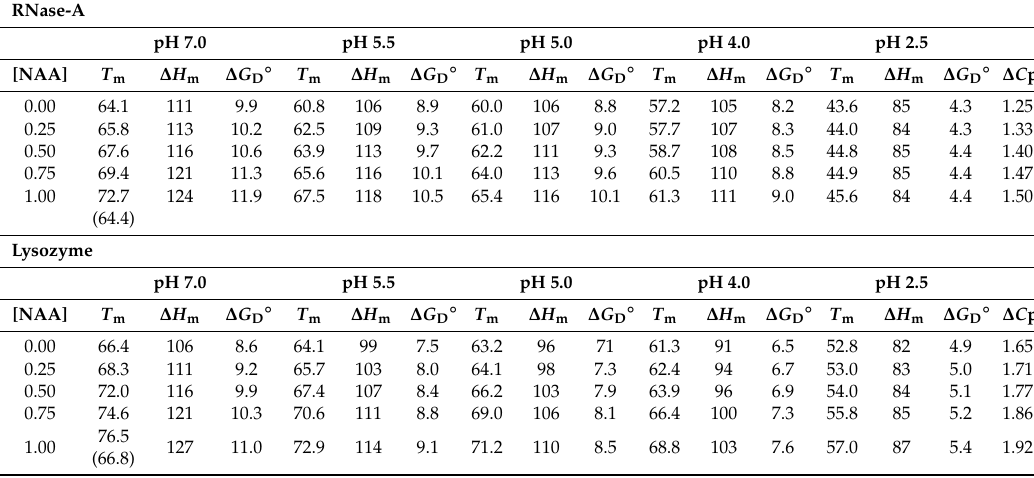
Figure 3. Effect of NAA on the tertiary structure of native proteins at 25 °C. Near-UV CD spectra of the native states of RNase-A ( A ) and lysozyme ( B ) in the absence and presence of NAA at pH 7.0.